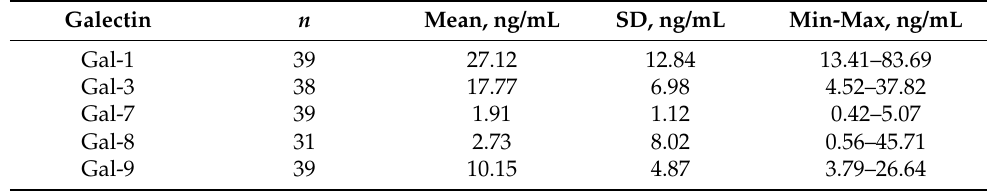
Table 2. Lung Cancer Patient Serum Galectin